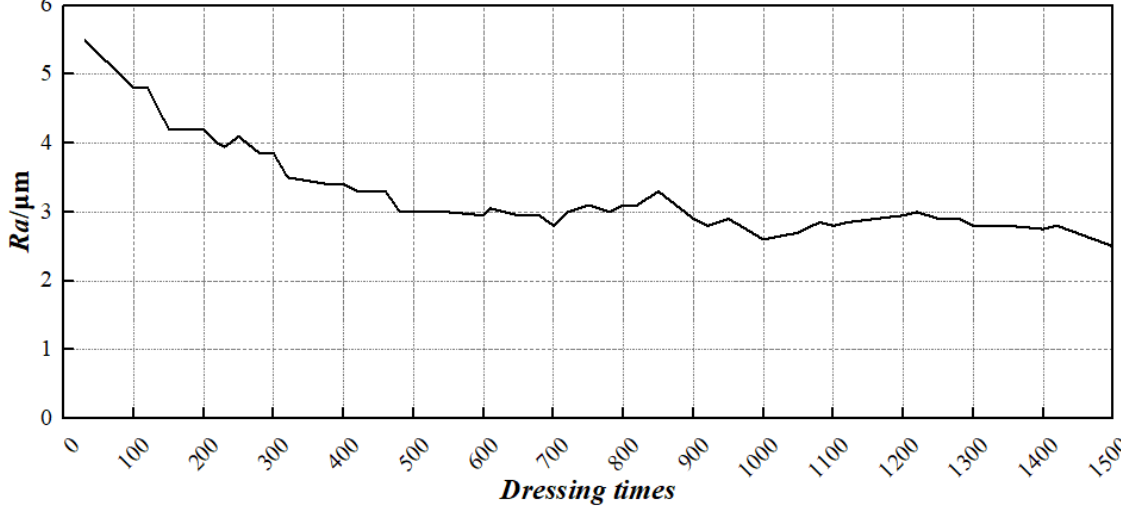
Figure 3. Variation law of grinding surface roughness Ra with the dressing times [6].